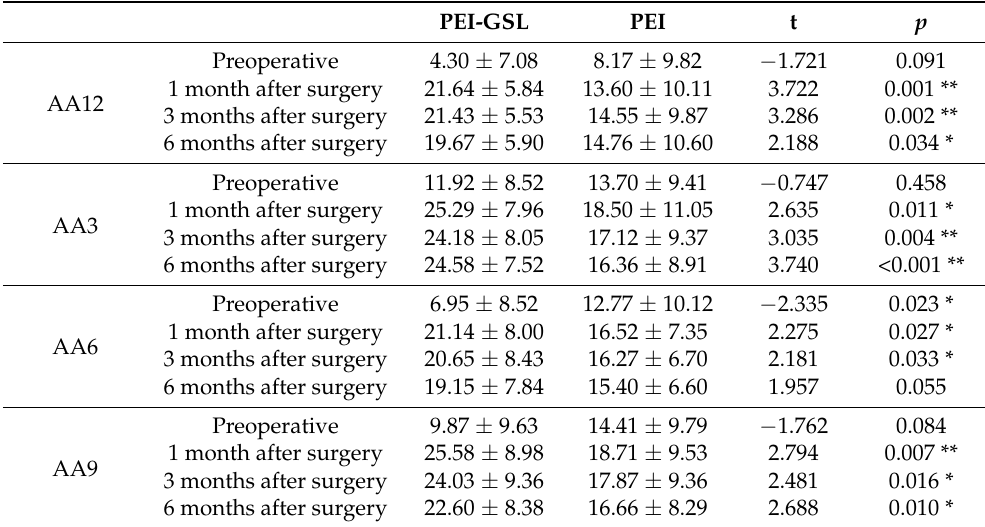
Table 5. Comparisons of AA between PEI-GSL and PEI